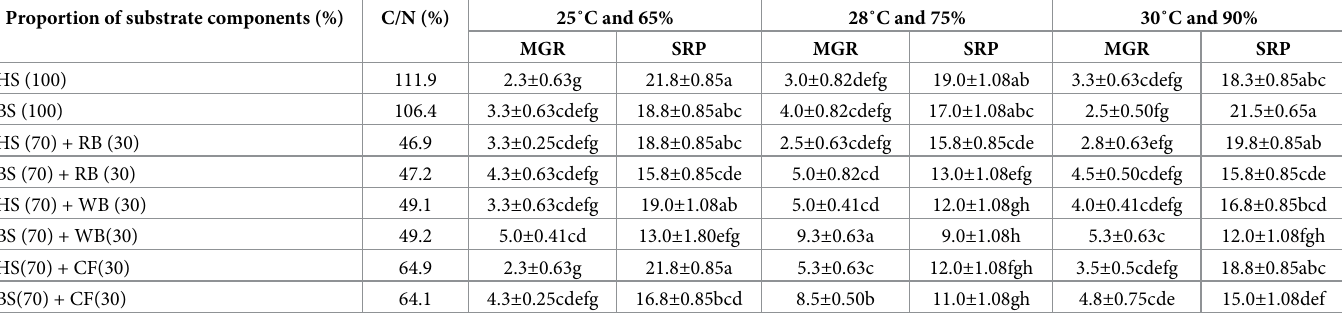
Table 2. Mycelia growth rate (MGR; mm day -1 ) and spawn run period (SRP) of Auricularia cornea on different substrates obtained from different concentration levels (%) of beech (BS) and hornbeam sawdust (HS), corn flour (CF), wheat (WB) and rice brans (RB) at 25, 28 and 30˚C and moisture contents of 65, 75 and 90%. Proportion of substrate components (%)